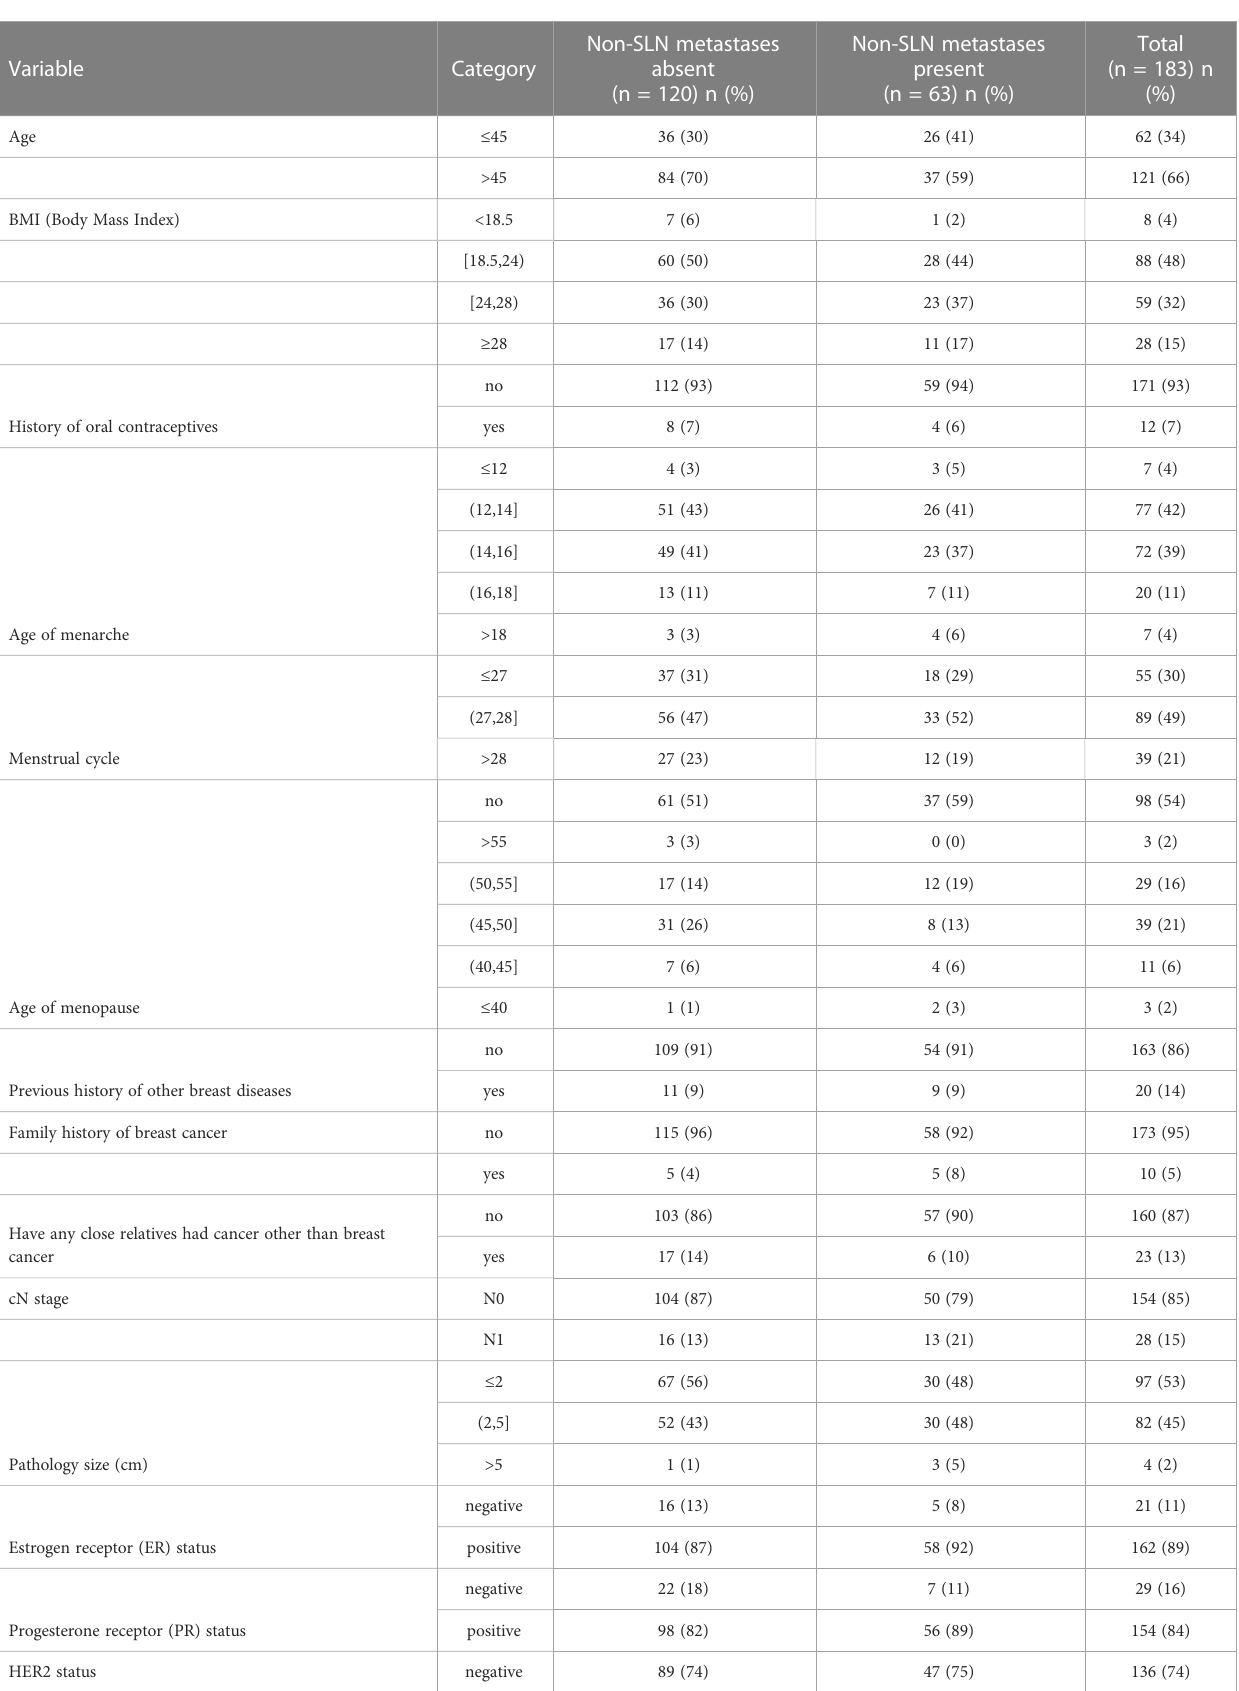
TABLE 1 Descriptive characteristics of training dataset